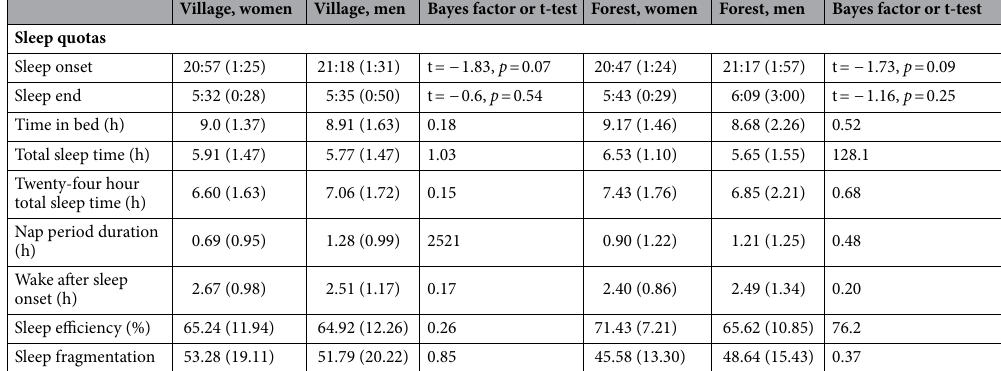
Village, women Village, men Bayes factor or t-test Forest, women Forest,